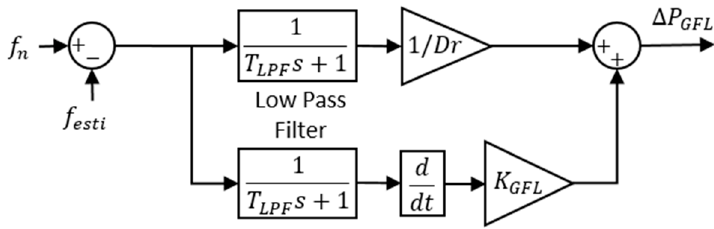
Figure 2. The grid-following frequency control method (GFL-FCM).